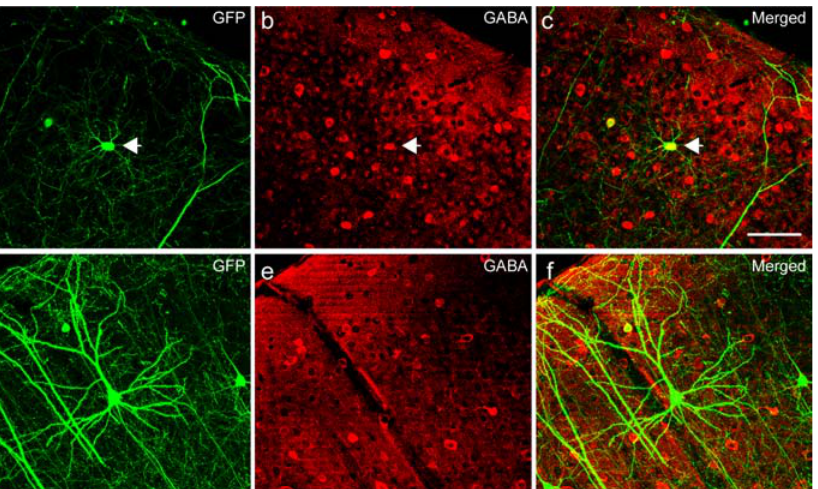
Figure 6. Remodeling Adult Non-Pyramidal Neurons in the Superficial Layers of the Visual Cortex Are Inhibitory GABAergic Interneurons (A) Confocal image stack of a coronal section containing the chronically imaged non-pyramidal neuron ‘‘ ttr ’’ is visualized by GFP staining (green, filled arrows) and is immunopositive for GABA (visualized in red) (B), overlay of GFP and GABA shown in (C). (D) Confocal image stack of a coronal section containing the chronically imaged pyramidal neuron ‘‘ dow ’’ is immunonegative for GABA (visualized in red) (E), overlay of GFP and GABA shown in (F). Scale bar: (A–F), 100 l m. DOI: